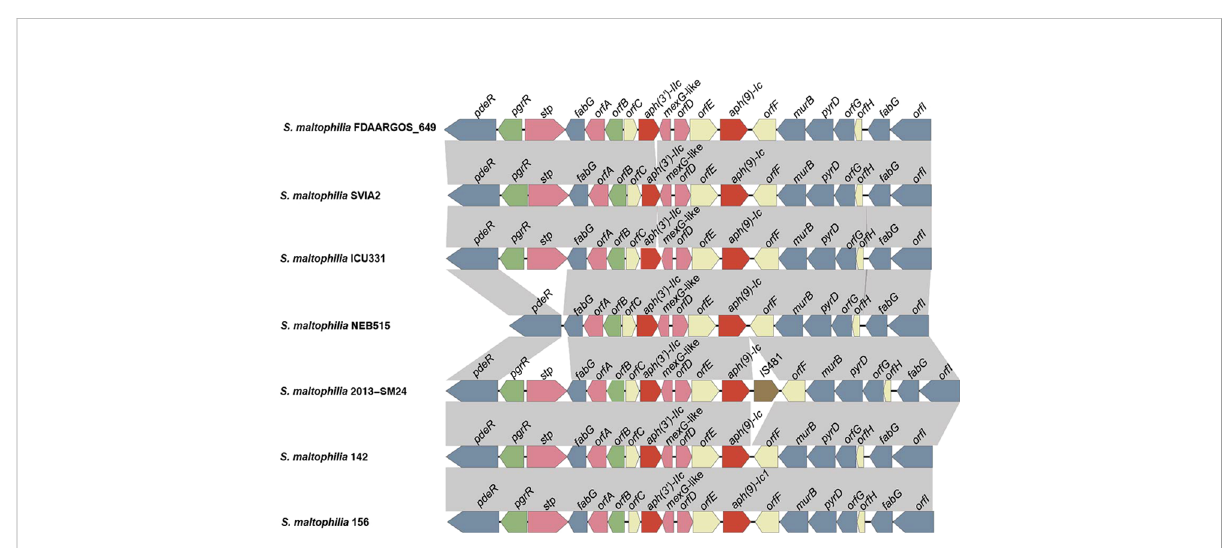
FIGURE 4 Comparativeanalysisofthe genomiccontextof the aph gene-relatedregions. ORFsareshown asarrowsdrawntoscale toindicatethedirectionof transcriptionand colored basedongenefunctionclassi fi cation. Grayshadingdenotesregionsofhomology.Fromlefttoright, thesegenes and functions areasfollows: pdeR , cyclicdi-GMPphosphodiesterase; pgrR ,helix-turn-helix(HTH)-type transcriptional regulator; stp , multidrugresistance protein; fabG , 3-oxoacyl-[acyl-carrier-protein]reductase; orfA , theGcn5-relatedN-acetyltransferases(GNAT)family; orfB ,ArsR family transcriptionalregulatoryprotein; orfC ,transmembraneprotein; aph(3 ’ )-IIc , aminoglycoside3 ’ -phosphotransferase; mexG -like, multidrugef fl ux RND transporterinhibitory subunit; orfD , tetracyclinerepressorproteinfamily; orfE , transmembrane protein; aph(9)-Ic , aminoglycoside9-phosphotransferase; orfF ,transmembraneprotein; murB , UDP-N-acetylenolpyruvoylglucosaminereductase; pyrD ,dihydroorotatedehydrogenase; orfG ,methyltransferase; orfH , transmembrane protein; fabG , 3- oxoacyl-[acyl-carrier-protein]reductase; orfI ,